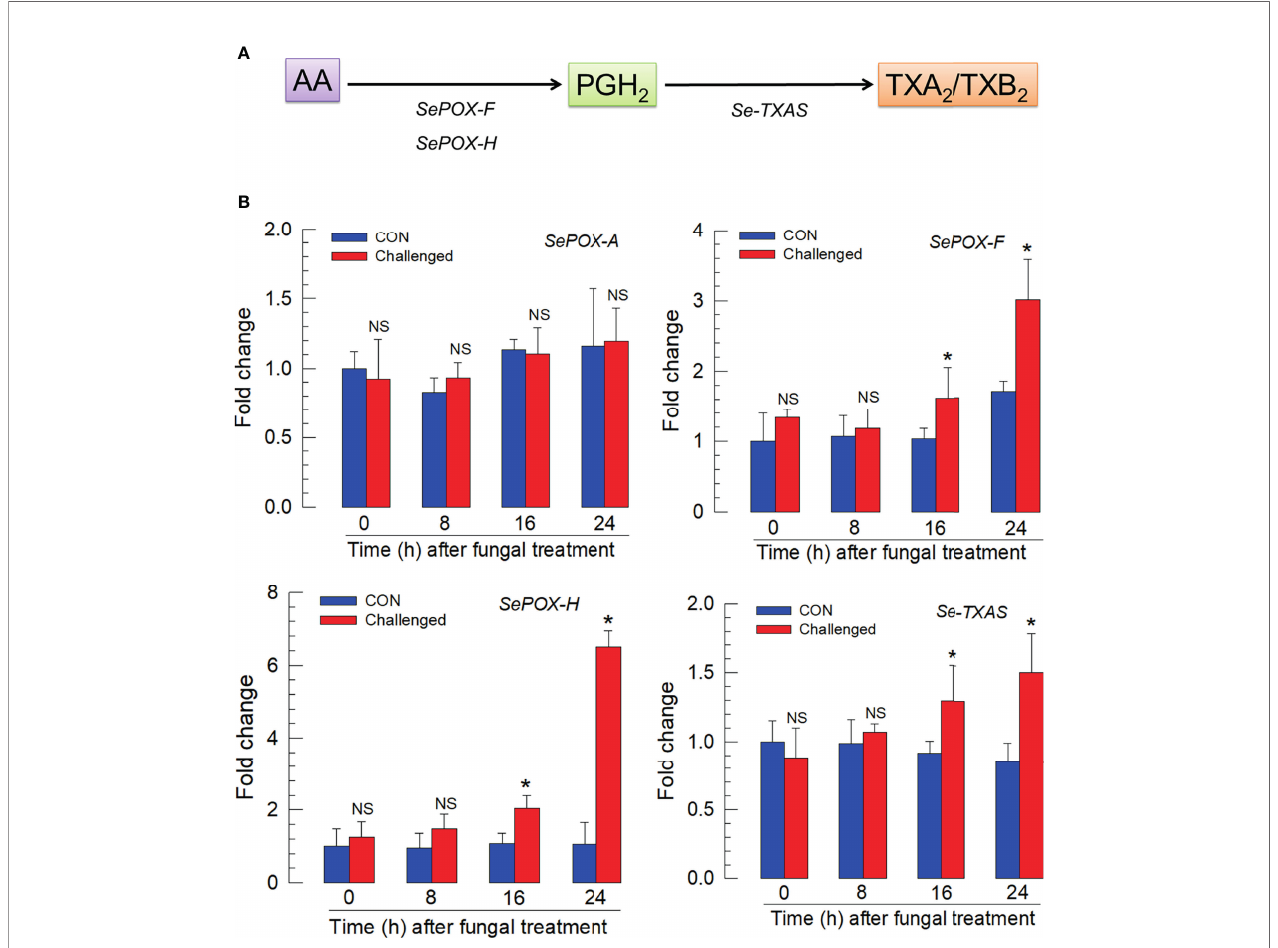
FIGURE 4 | Up-regulation of thromboxane biosynthesis in S. exigua hemocytes following M. rileyi infection. Panel (A) presents a likely thromboxane biosynthetic pathway. AA is oxygenated to PGH 2 by two peroxinectins, SePOX-F ’ and SePOX-H. Thromboxane A 2 ( ‘ TXA 2 ’ ) is then formed by Se-TXAS and non-enzymatically converted to thromboxane B 2 ( ‘ TXB 2 ’ ). Panel (B) reports the in fl uence of M. rileyi infection on accumulations of mRNAs encoding SePOX-A, SePOX-F, SePOX-H, and Se-TXAS. Each treatment was replicated three times. Data analyzed and presented as described in Methods . ‘ NS ’ , no signi fi cant difference. Asterisks above standard deviation bars indicate signi fi cant difference among means at Type I error = 0.05 (LSD